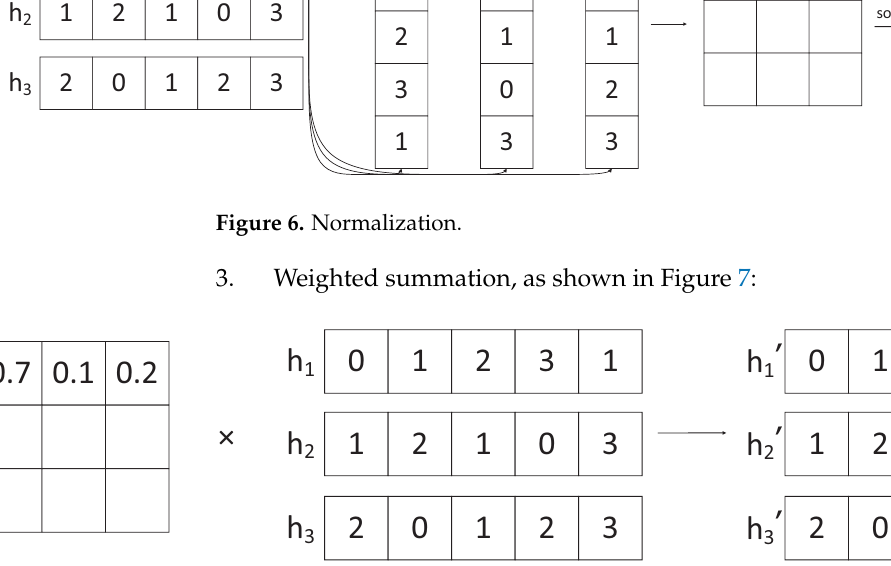
Figure 7. Weighted